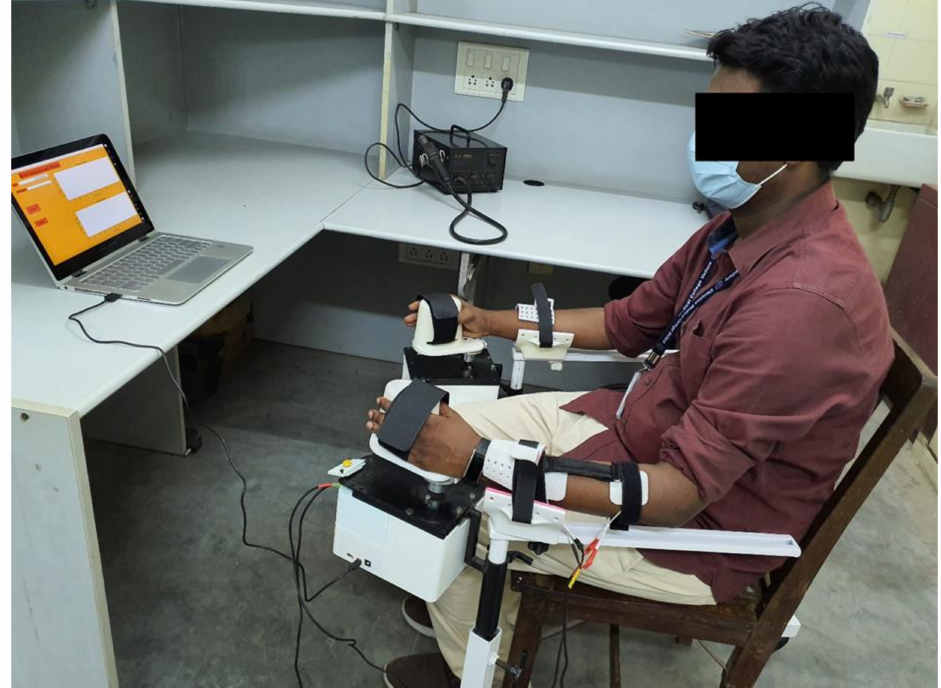
Figure 5. Experimental setup. The figure shows a volunteer using the encoder-controlled FES. The angles are set on the righthand side and the left wrist is stimulated to the same degree of flexion/extension as the set